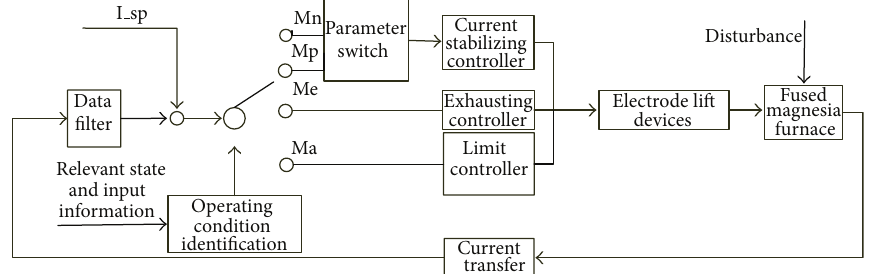
Figure 8: Control strategy of arm-type electro-fused magnesia furnace. I sp is the current setpoint. Mn means normal condition. Mp means padding condition. Me means exhausting condition, and Ma is limit condition.